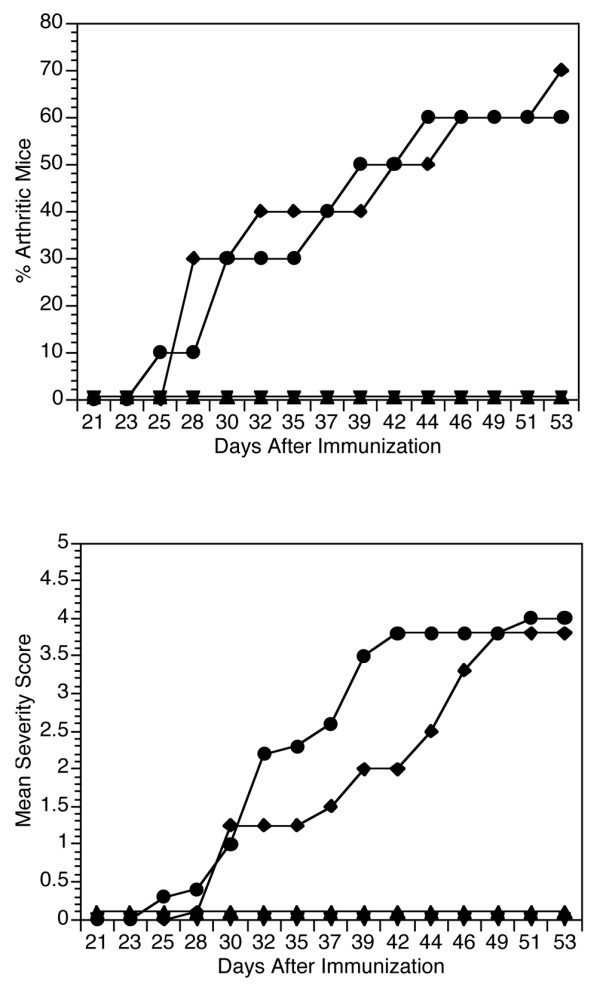
Co-immunization of DR4 transgenic mice with type II collagen and analog peptides. Groups of DR4 transgenic mice were co-immunized with 50 μg of type II collagen (CII) alone (n = 18; circles) or with 50 μg of CII plus 1.2 mg of the analog peptide CI256–276, (F263N, E266D) (n = 16; upward triangles), with 50 μg of CII plus 1.2 mg of the analog peptide CII256–276 (F263N, E266A) (n = 10; downward triangles), or with 50 μg of CII plus 1.2 mg of the analog peptide CII256–276 (E266D) (n = 10; diamonds) and observed for arthritis. Results are incidences (upper panel) and mean severity scores (lower panel) of arthritis observed at various time points after immunization.